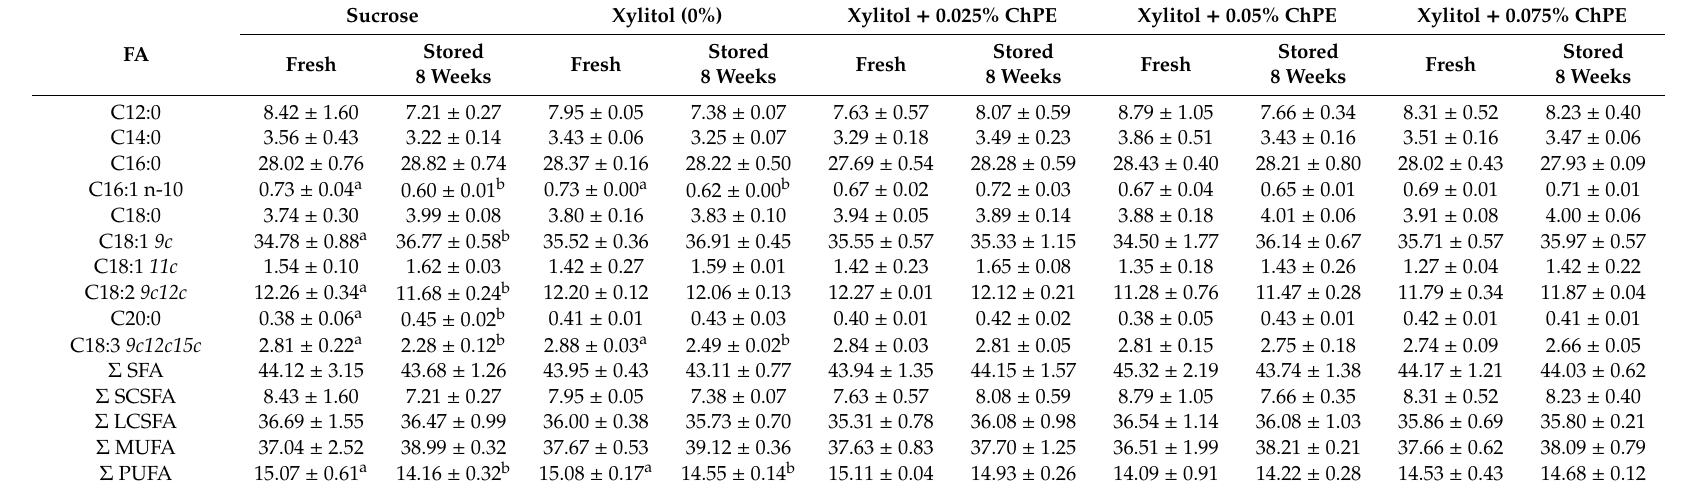
Table 4. The content of main fatty acids (g / 100 g FA) in fat extracted from mu ffi ns, fresh or stored for 8